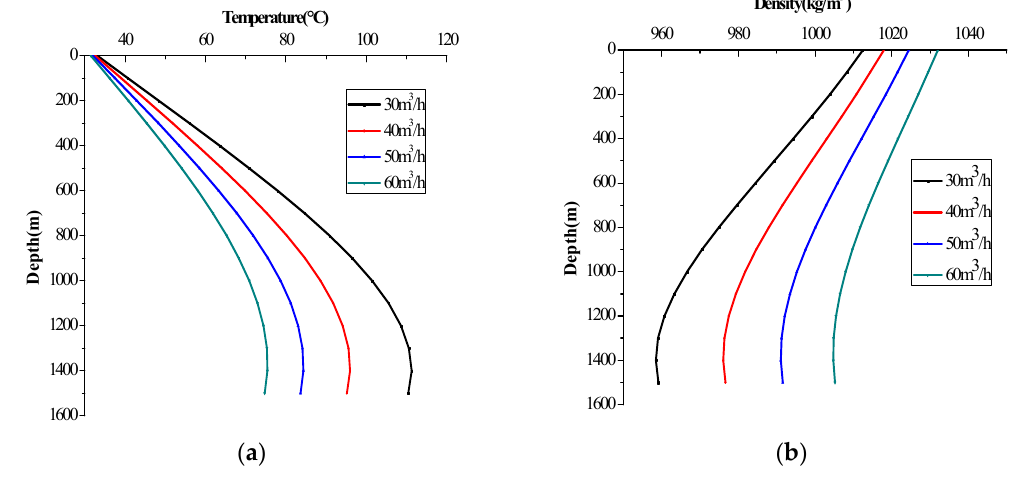
Figure 6. Temperature ( a ) and ECD ( b ) in the annulus with the flow rate (circulating 8 h). The geothermal gradient is another important parameter to temperature distribution in the annulus (Figure 7a). The geothermal gradient increases 42.9% or decreases 28.6%, the temperature of the bottom hole elevates 20 °C or reduces 30 °C. The ECD distributions in the annulus under various will lead to a large error in predicting the temperature distribution and calculating the ECD in the annulus.